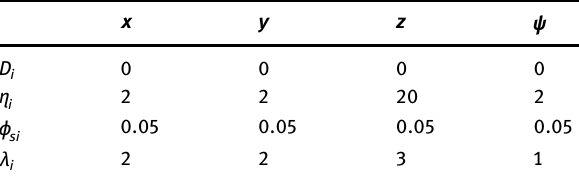
Table 4: Controller gains for all four control subsystems for SMC